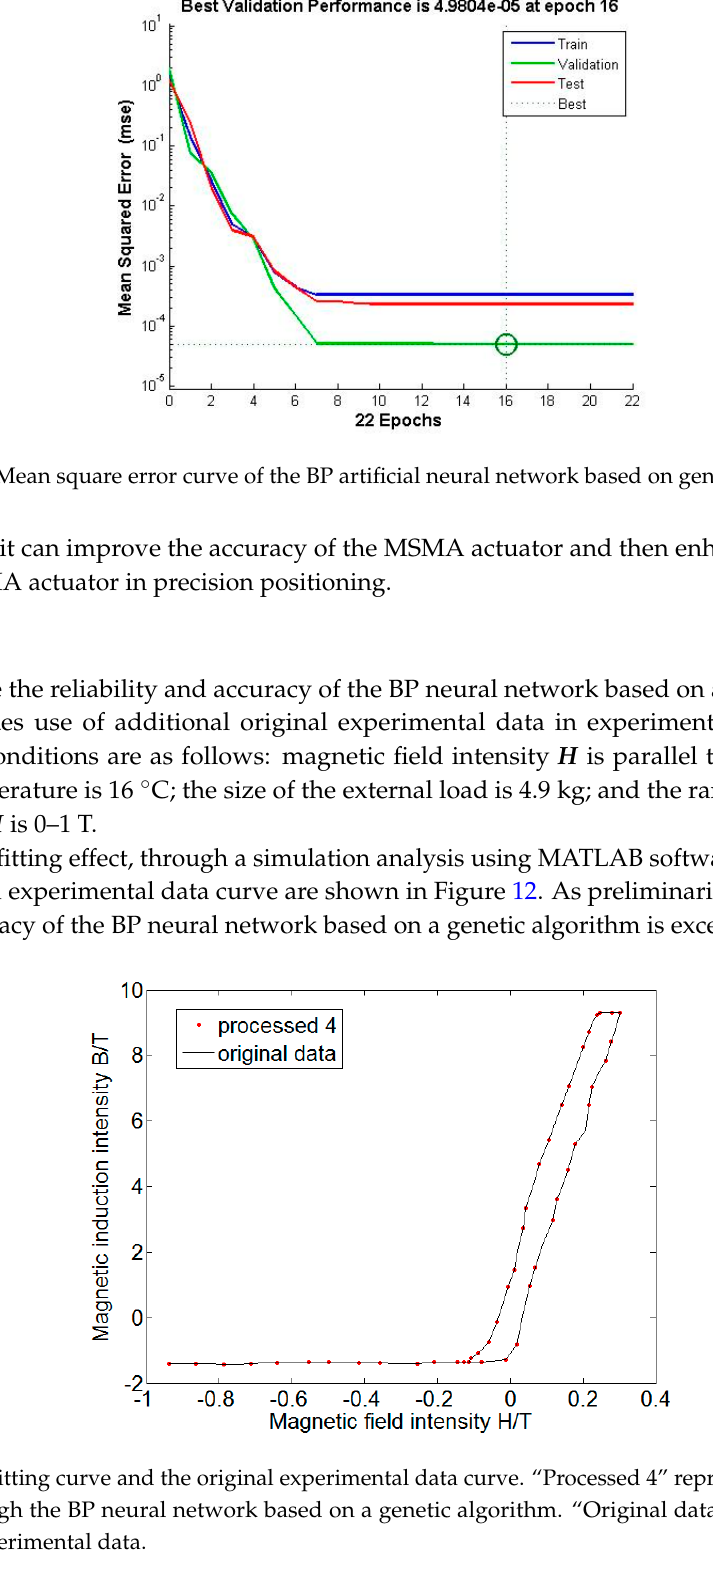
Figure 10. Fitting-error-rate curve. “Original” and “improved” represent the fitting-error-rate curve of the BP artificial neural network and BP artificial neural network based on genetic algorithms, respectively.